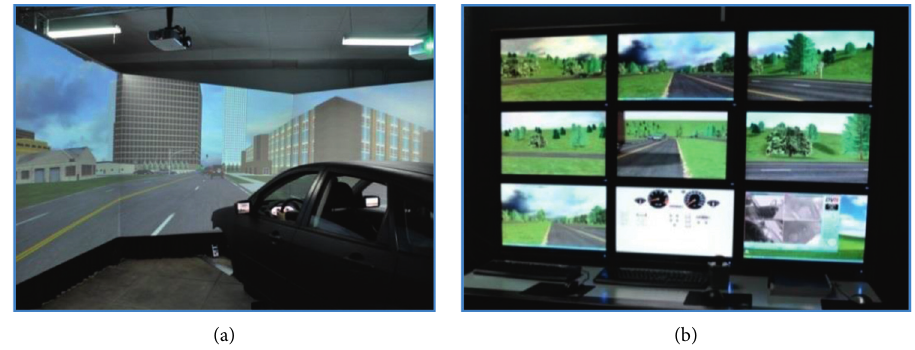
Figure 1: Illustration of the driving simulator system.